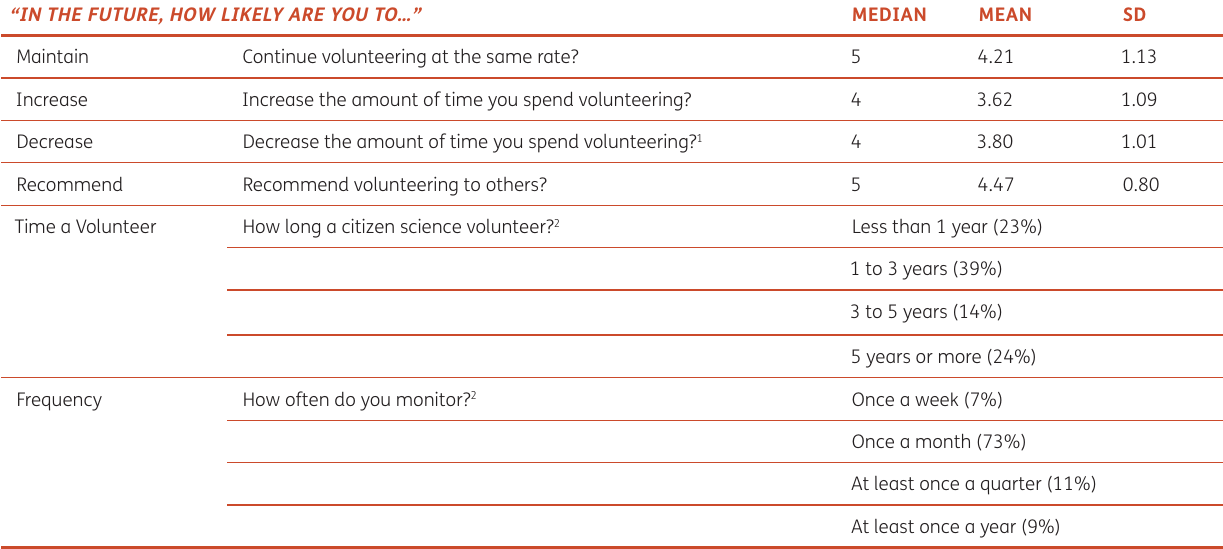
Table 8 Descriptive statistics for indicators of commitment. 1 Coding reversed. 2 Combined into fewer groups for clarity and statistical analysis due to low count. Twice a year (n = 4) was combined with at least once a year (n = 19) and every other month (n = 8) was combined with at least once a quarter (n = 10). Most watershed groups encourage citizen scientists to monitor once a month. SD = standard